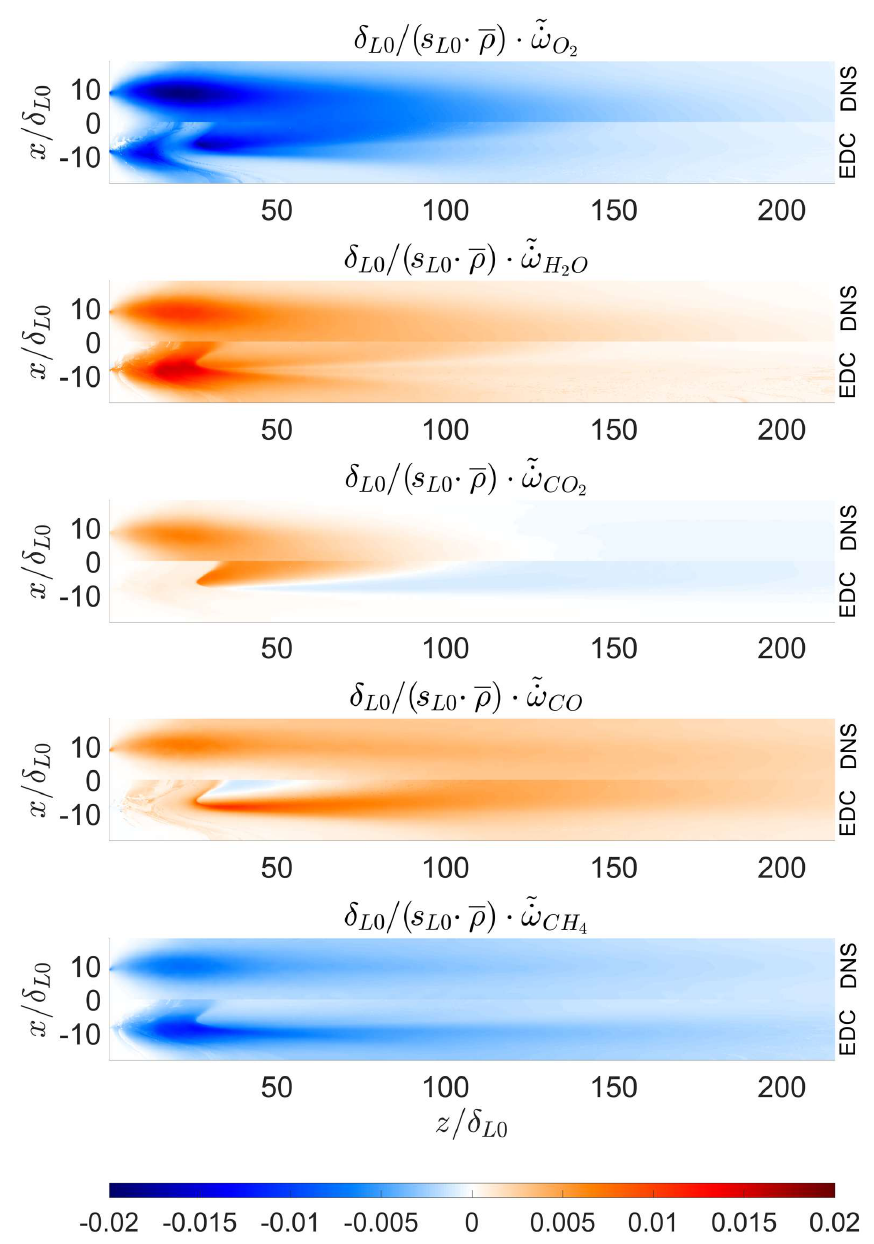
Figure 2. Observed mean chemical production rate in the numerical simulations and the best possible prediction using the Eddy Dissipation Concept.